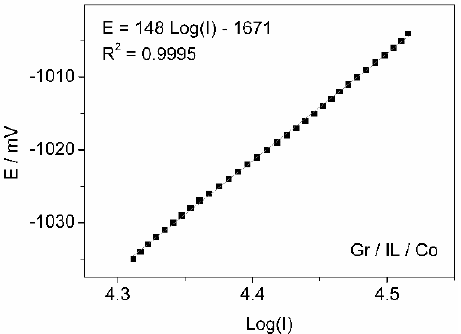
Figure 7. Tafel slope for the Gr / IL / Co system measured in the phosphate bu ff er pH = 7, Ω = 5 mV · s − 1 Figure 7. Tafel slope for the Gr/IL/Co system measured in the phosphate buffer pH = 7, Ω  5 mV ∙ s − 1 .